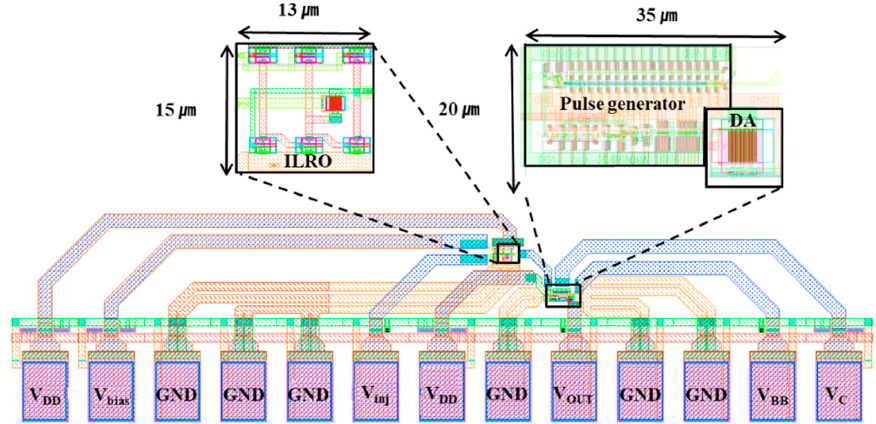
Figure 10. Chip layout of the proposed ultrawideband (UWB) transmitter with RF clock harvester.